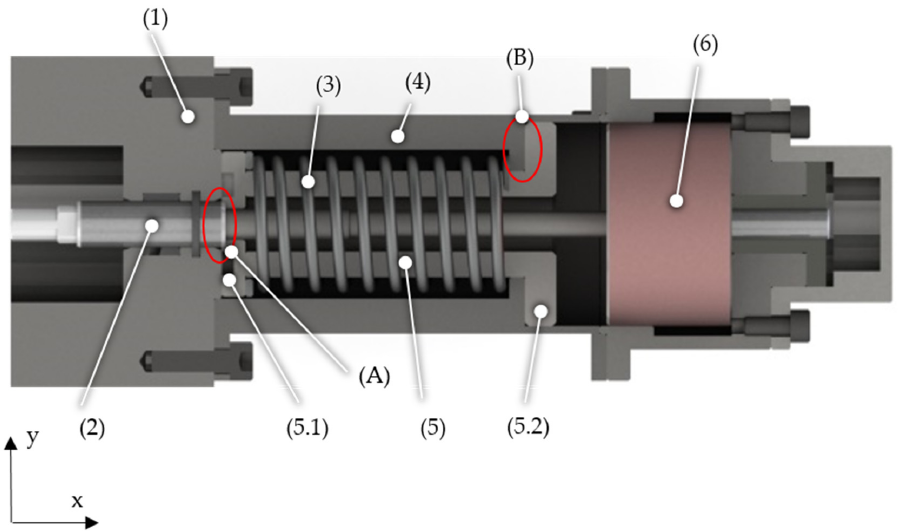
Figure 10. Sectional view of the magnetic relief system.